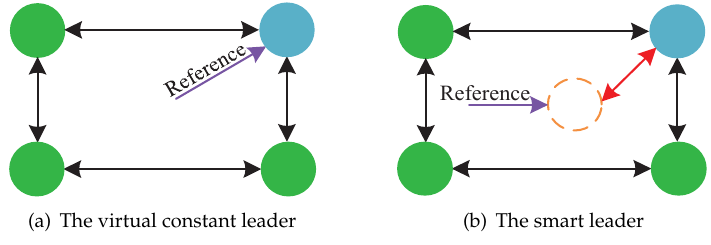
Figure 2. Schematic of the virtual constant and the smart leader in the leader–follower